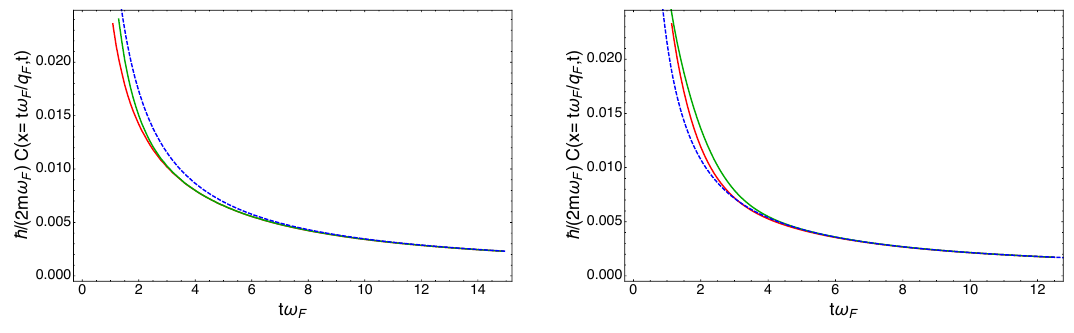
Figure 10: Correlation function C ( x , t ) ≡ 〈 σ ( x , t ) σ ( 0,0 ) 〉 in the non-equilibrium steady state (62) for x = 2 α t as a function of t at c = 4, for D = 1 /π (left) and D = 1 / ( 2 π ) (right). The three curves depict the real part (red), the modulus (green) and the GHD approximation (dashed